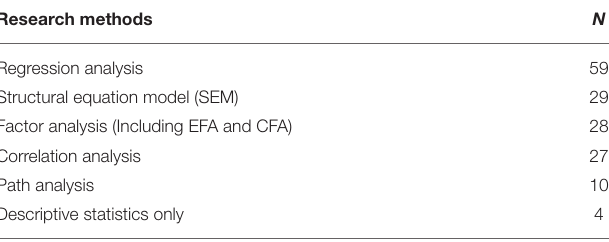
TABLE 6 | Top 10 countries in the volunteer motivation research